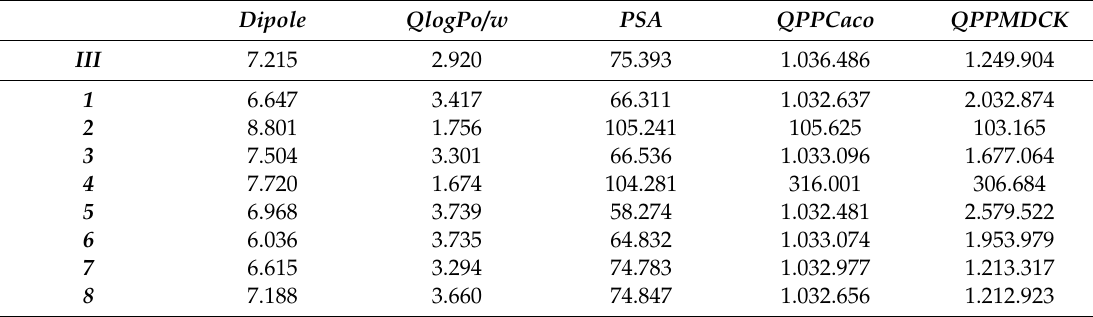
Table 2. Key drug-like properties for the compounds 1–8 , object of the present work. Dipole QlogPo / w PSA QPPCaco